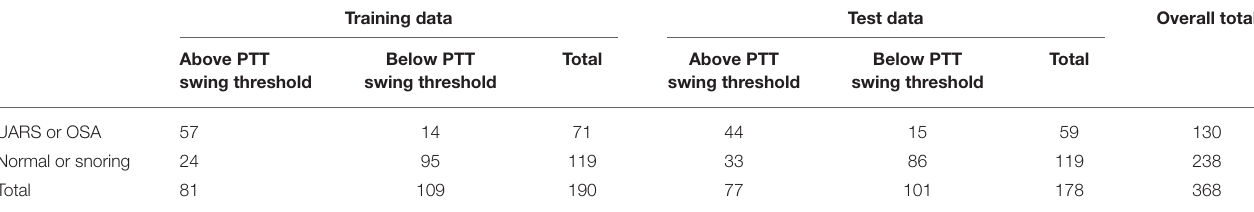
TABLE 7 | Number of children above and below PTT respiratory swing threshold in both training and test dataset. Training